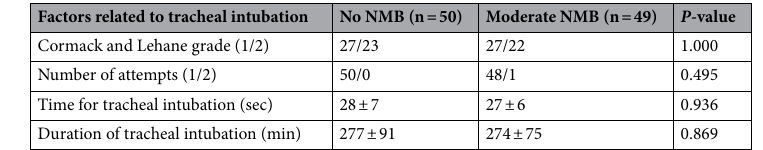
Table 2. Factors related to tracheal intubation. Values are means ± SD or number of patients (%). NMB neuromuscular blockade.